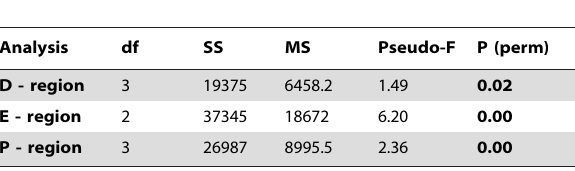
Table 3. PERMANOVA analysis by region. D: depletion, E: local extinction, P: